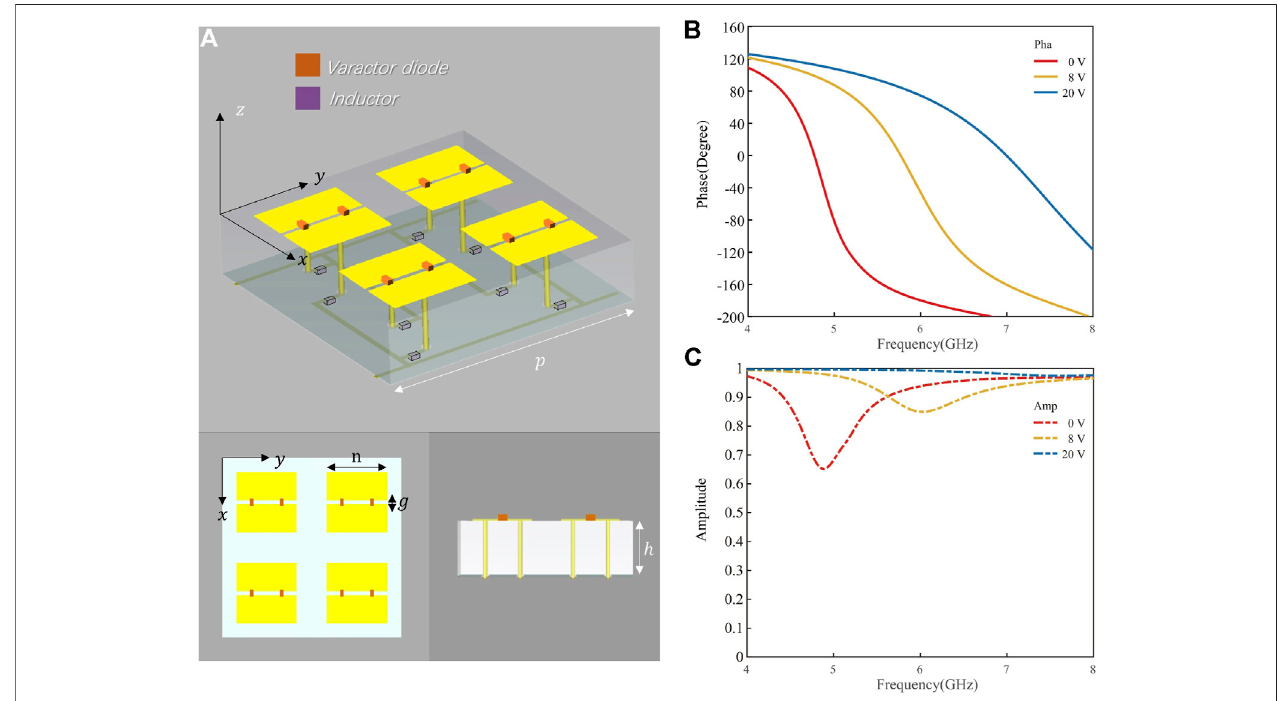
FIGURE 2 | (A) Structure of supercell (B) phase responses of supercell at 0, 8, and 20 V (C) amplitude responses of supercell at 0, 8, and 20 V.